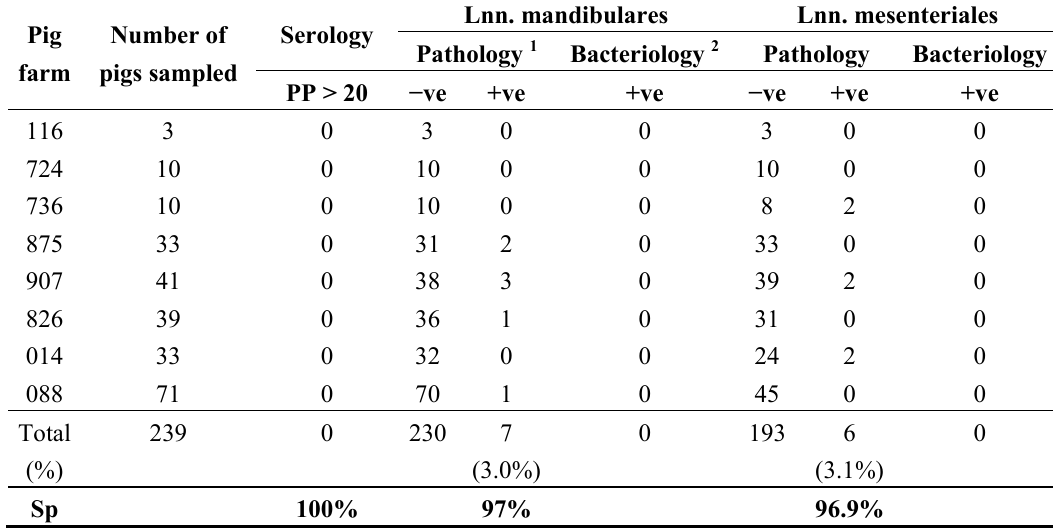
100% 97% 96.9% 1 Positive when granulomatous lesions were seen in the submaxillary lymph nodes during pathological examination. 2 Positive when M. avium bacteria were detected by bacteriological examination